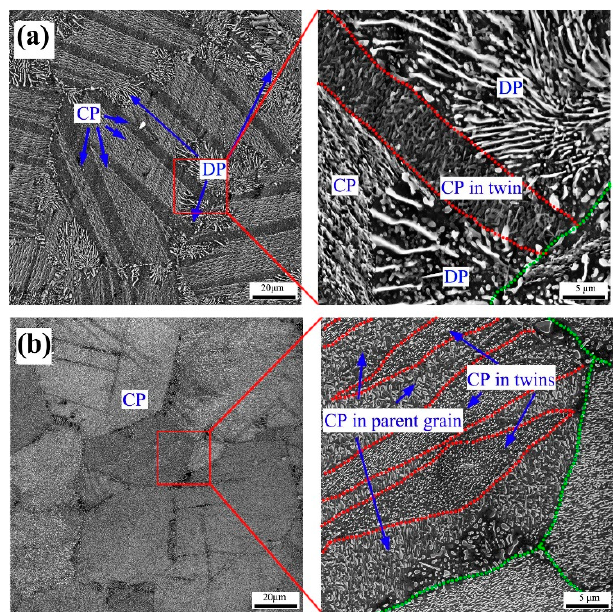
Figure 2. SEM micrographs extruded AZ91 rods which subjected torsion and subsequent aging ( a ) center position and ( b ) edge position. Green dotted lines and red dotted lines outline the grain boundaries and twin boundaries, respectively. The micrographs at the right-side were taken at higher magnification from the corresponding marked areas [27].